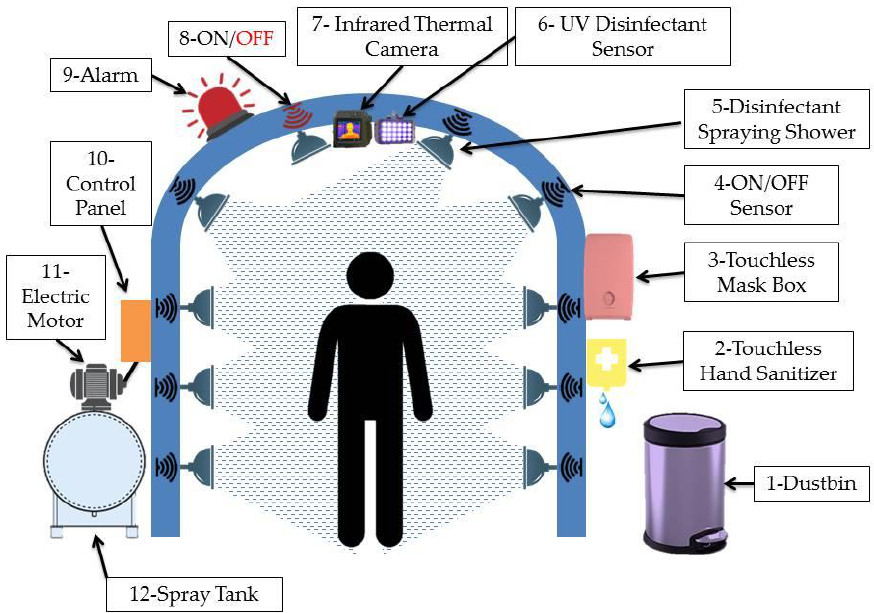
Figure 2. Showing the proposed automated disinfectant spraying walk-through gate.